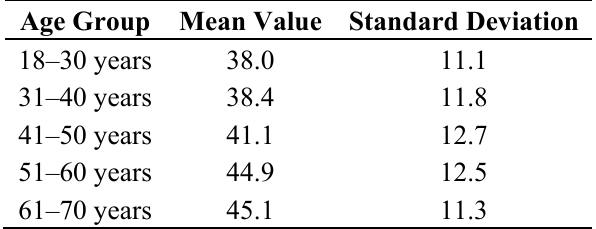
Table 1. Skin hydration mean basal values and standard deviations.